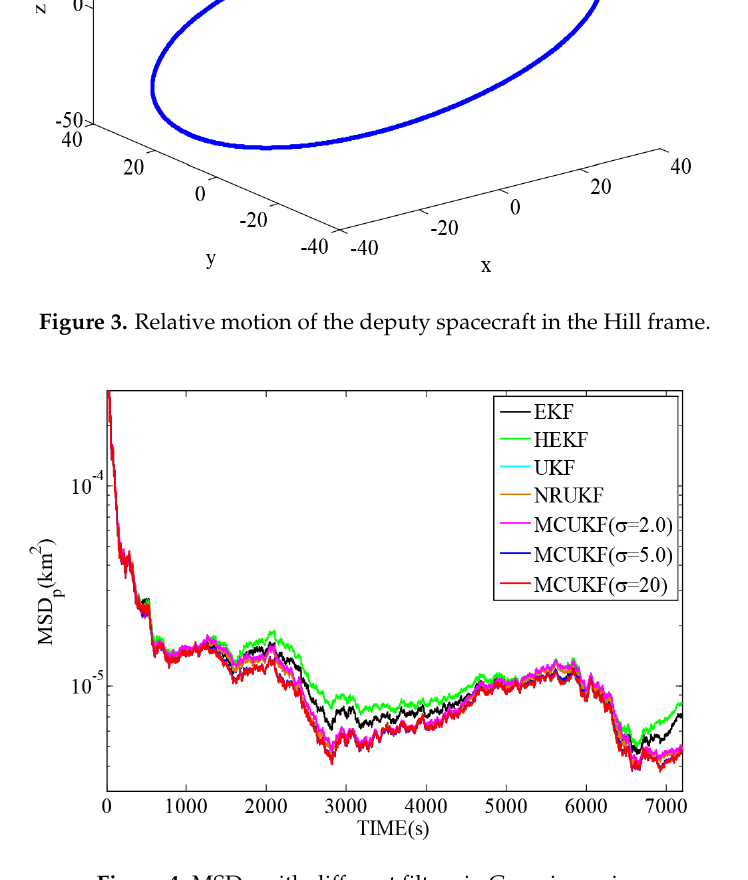
Figure 4. MSD p with different filters in Gaussian noises.